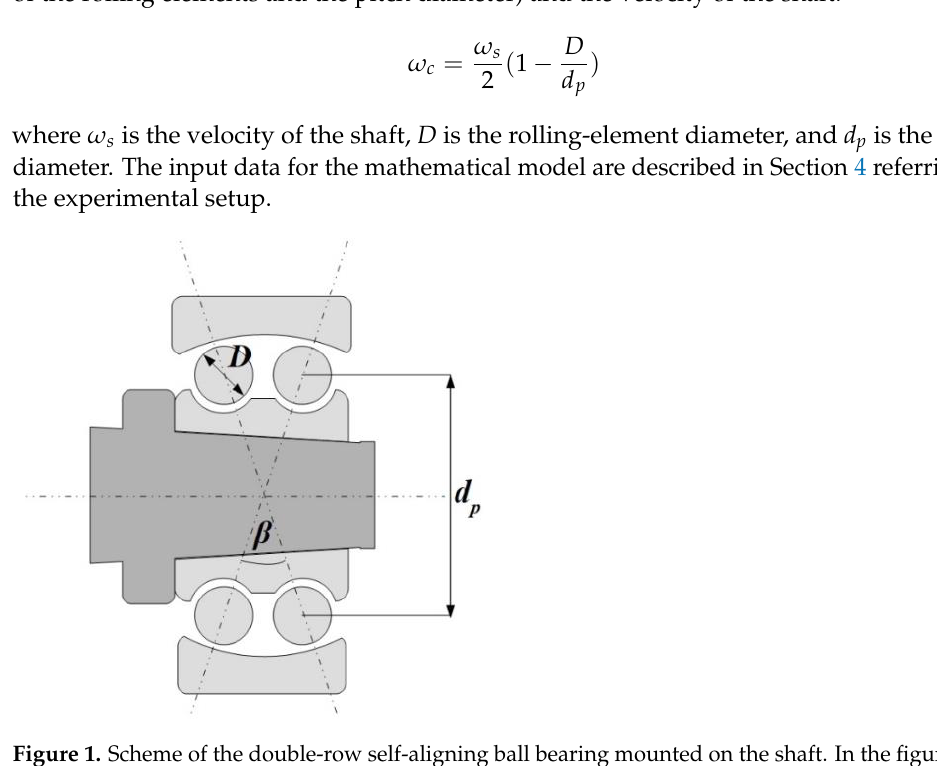
Figure 1. Scheme of the double-row self-aligning ball bearing mounted on the shaft. In the figure, the ball diameter D , pitch diameter d p , and β are